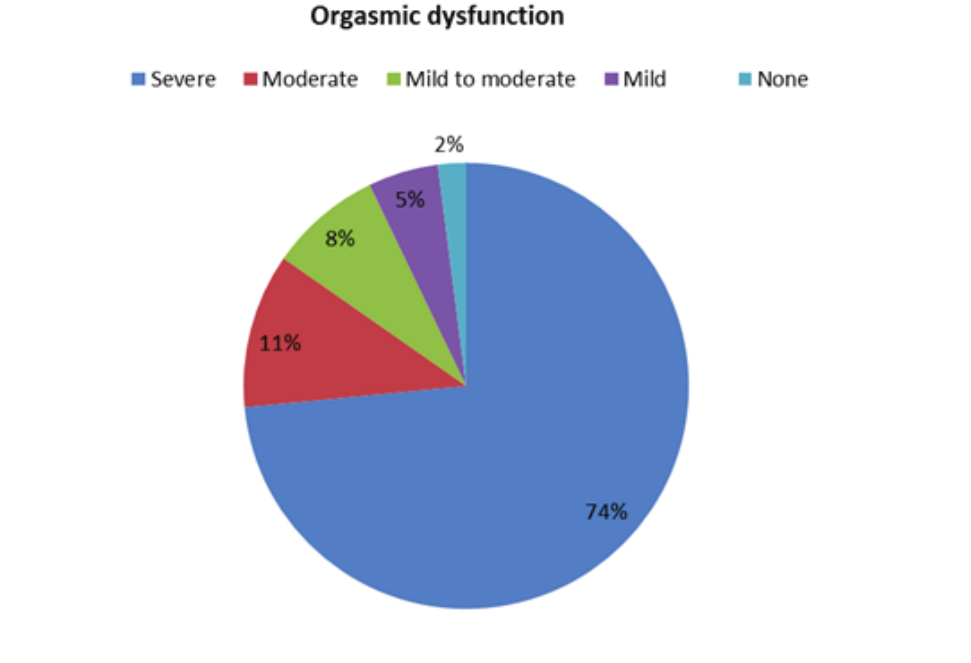
Figure 5: The severity of orgasmic dysfunction among the studied